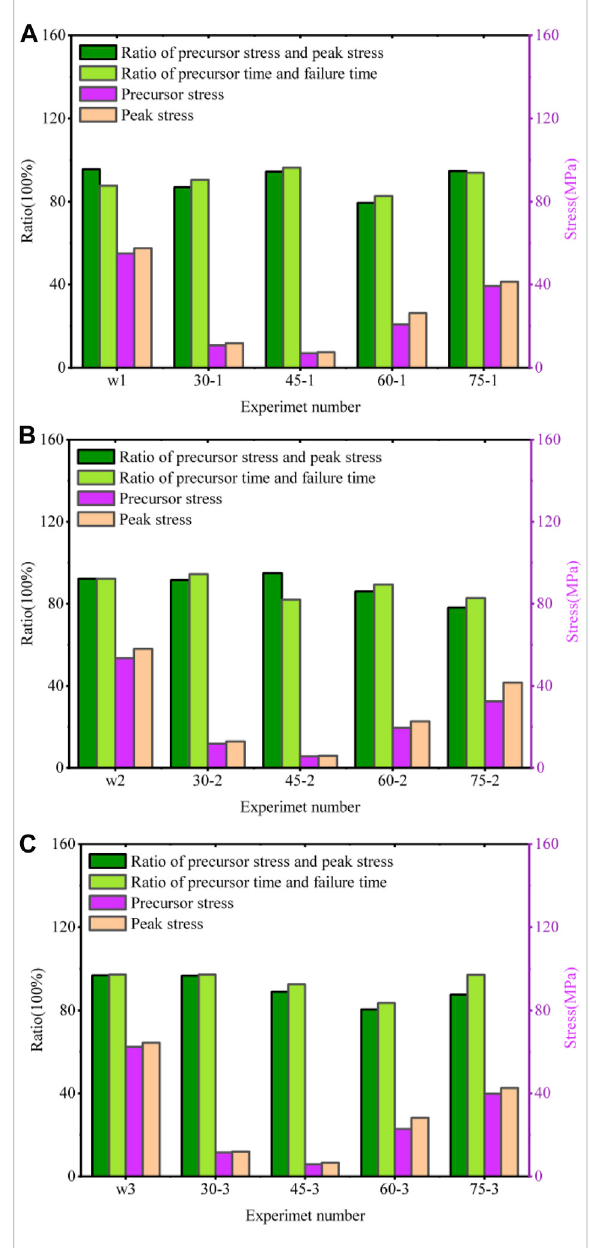
FIGURE 9 A statistical analysis of the time ratio, the stress ratio, and the features of stress. (A) w1~75-1, (B) w2~75-2, and (C)